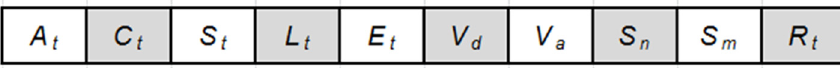
Figure 2. An illustration of the structure of a candidate chromosome. Constituent navigation and flocking parameters are represented as the genes of the chromosome.